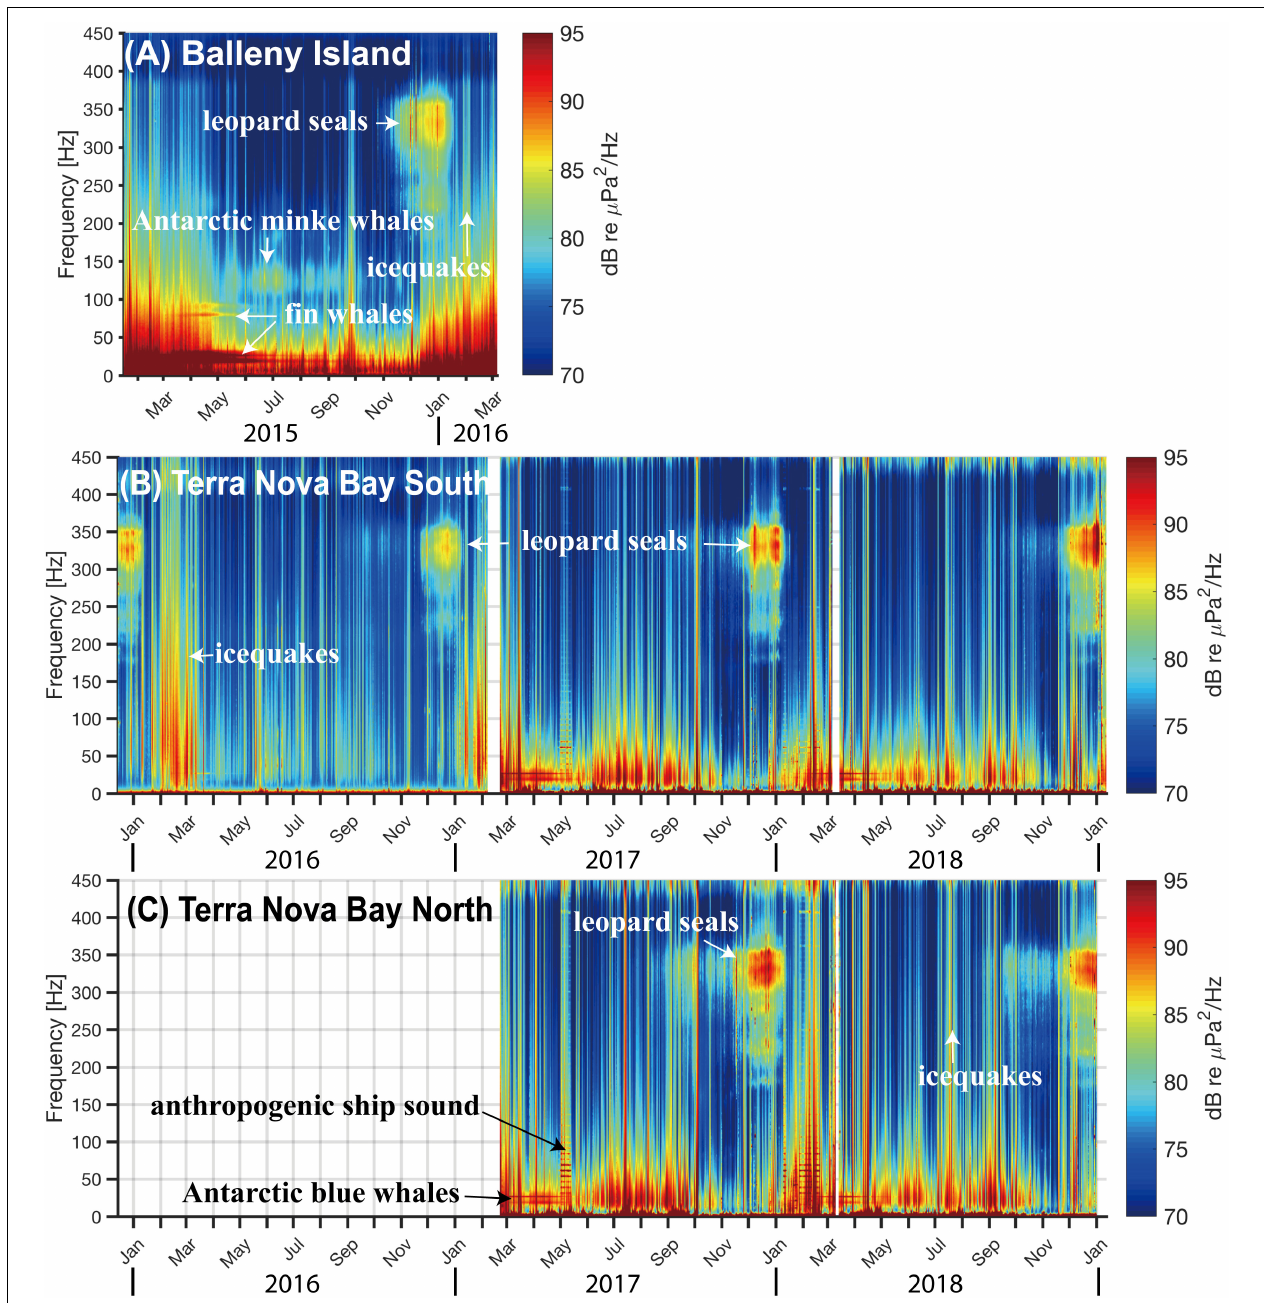
FIGURE 2 | Long-term spectrograms of recordings from (A) the BI region during February 2015–March 2016, (B) TNB south during December 2015–January 2019, and (C) TNB north during February 2017–January